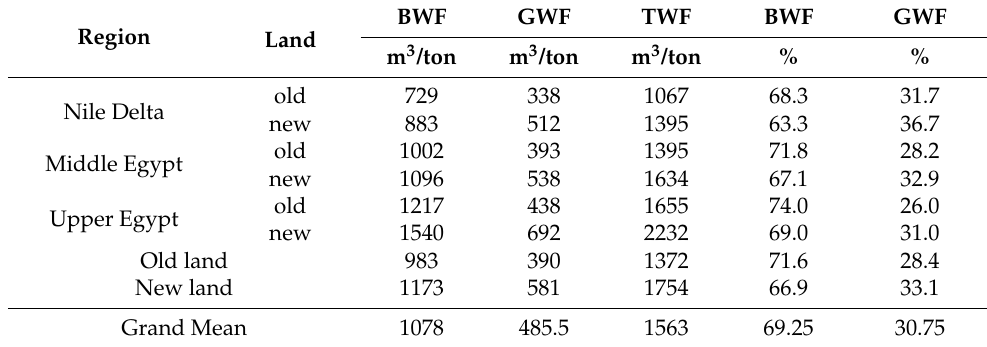
Table 8. Mean blue and grey water footprints and total water footprint for maize for three climate regions and two soil types, i.e., old and new land.